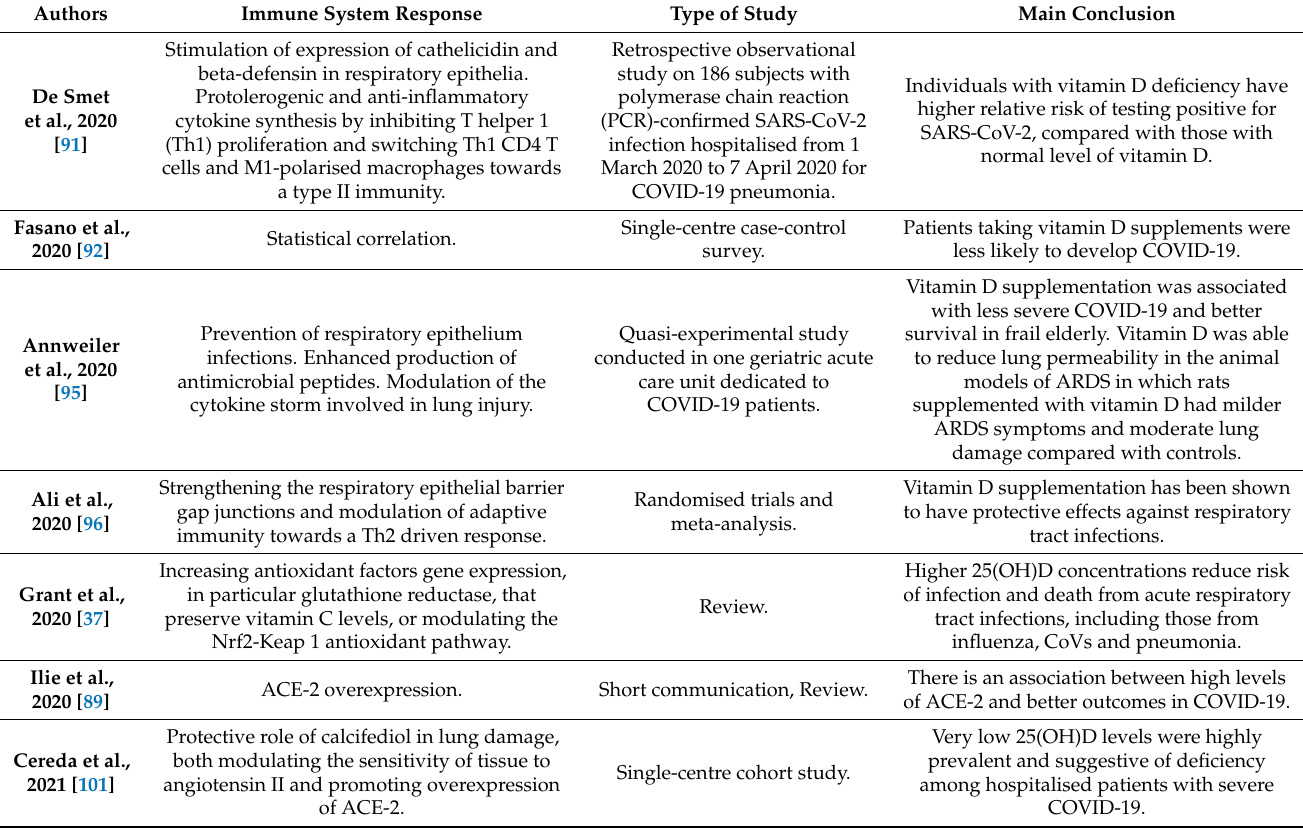
Table 2. Correlations between vitamin D and